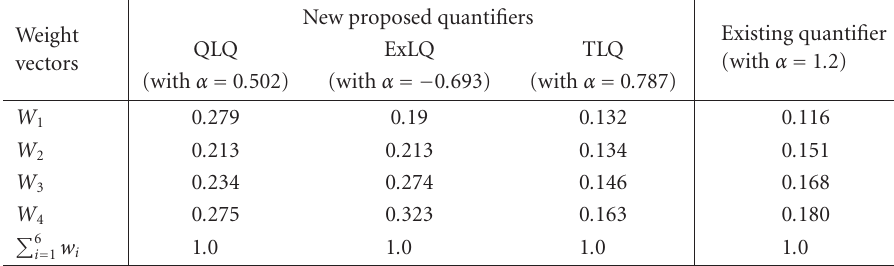
Table 4.3. Weight vectors for the best 4